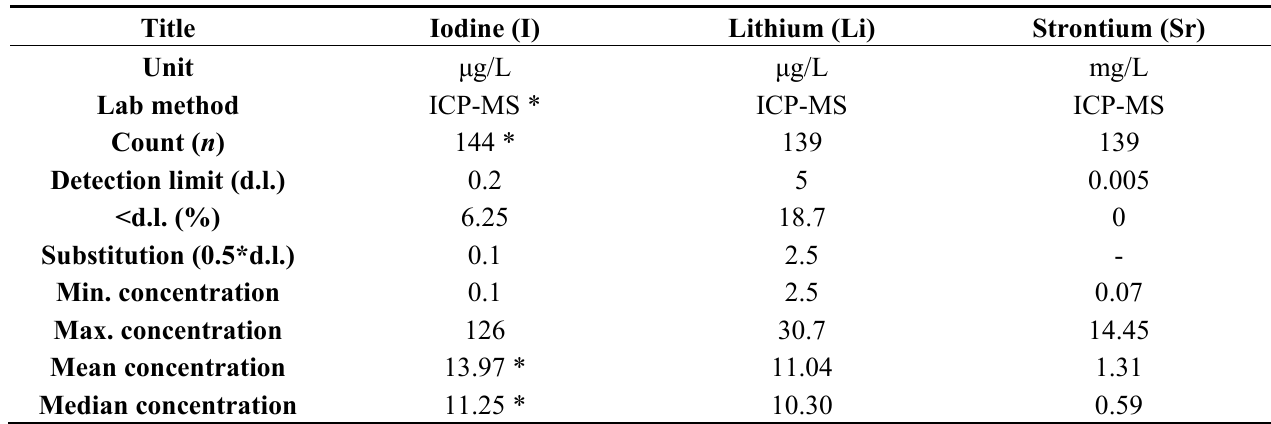
Table 1. Summary of the iodine, lithium, and strontium datasets (concentrations in drinking water) used in this study.